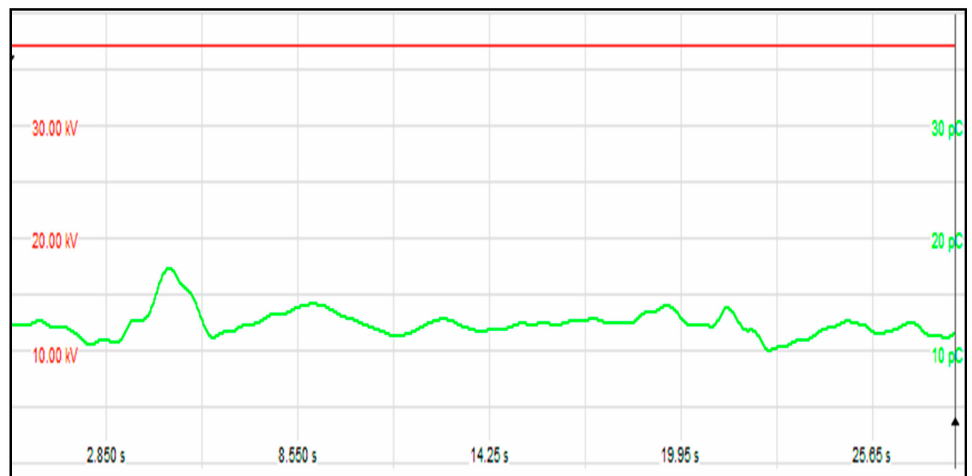
Figure 16. Relation between the raise of induced voltage and PD